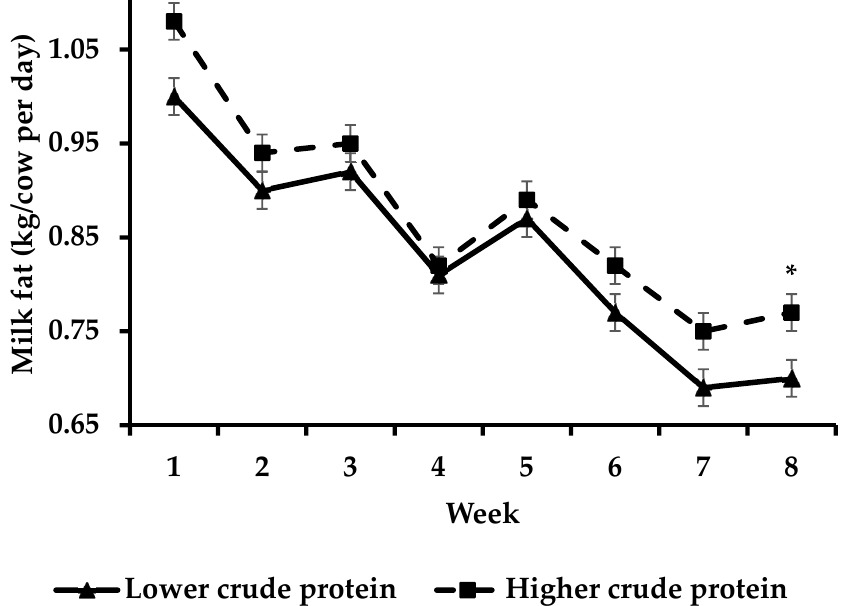
Figure 3. Effect of protein supplementation strategy × week on milk fat yield [asterisks (*) indicate a significant difference for week].